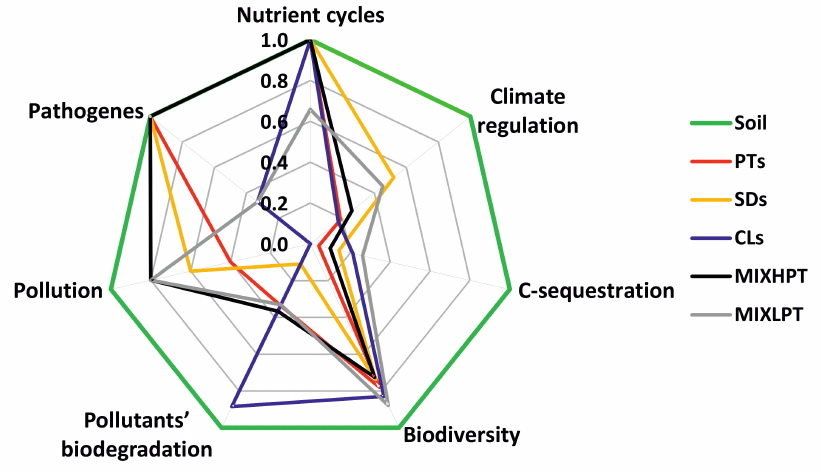
Figure 7. Estimation of ecosystem services (1 is the highest) and disservices (1 is the lowest) provided by different groups of materials: peats (PTs), sediments (SDs), cultural layers (CLs), high-peat (MIX HPT ), and low-peat (MIX LPT ) mixtures in relation to